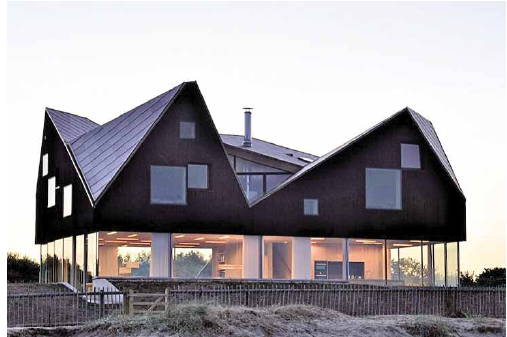
Fig. 25. “Kultflux” pavilion, Vilnius, archit.